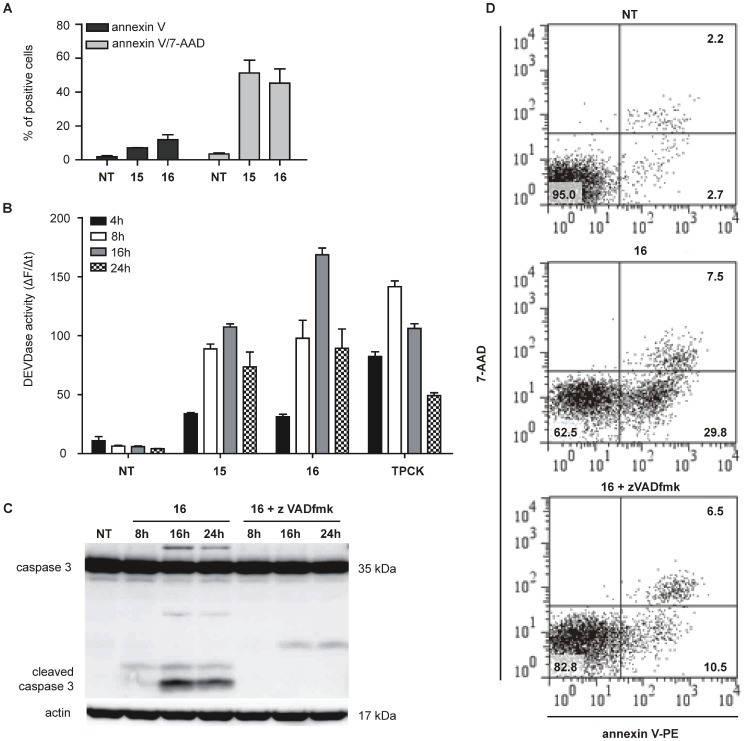
zVADfmk inhibits amidinopiperidine-based compounds induced apoptosis.(A) The determination of Annexin V and 7-AAD positive Ramos cells treated with compounds 15 or 16 for 24 h. The data present the percentage of gated cells. (B) Caspase 3/7 activity was determined in cell lysates of Ramos cells treated for 4 h, 8 h, 16 h and 24 h with either 50 µM inhibitor or 10 µM TPCK, used as a positive control. Cleavage of Ac-DEVD-AFC in whole cell lysates was determined spectrofluorometrically. The results are presented as changes in fluorescence as a function of time. (C) Western blot analysis of the caspase-3 processing. Cells were treated for indicated time periods in the presence of zVADfmk (50 µM) and/or compound 16 (50 µM). (D) Analysis of Annexin V/7-AAD positive cells after 16 h treatment with compound 16 in the absence or presence of zVADfmk. NT, non-treated cells.